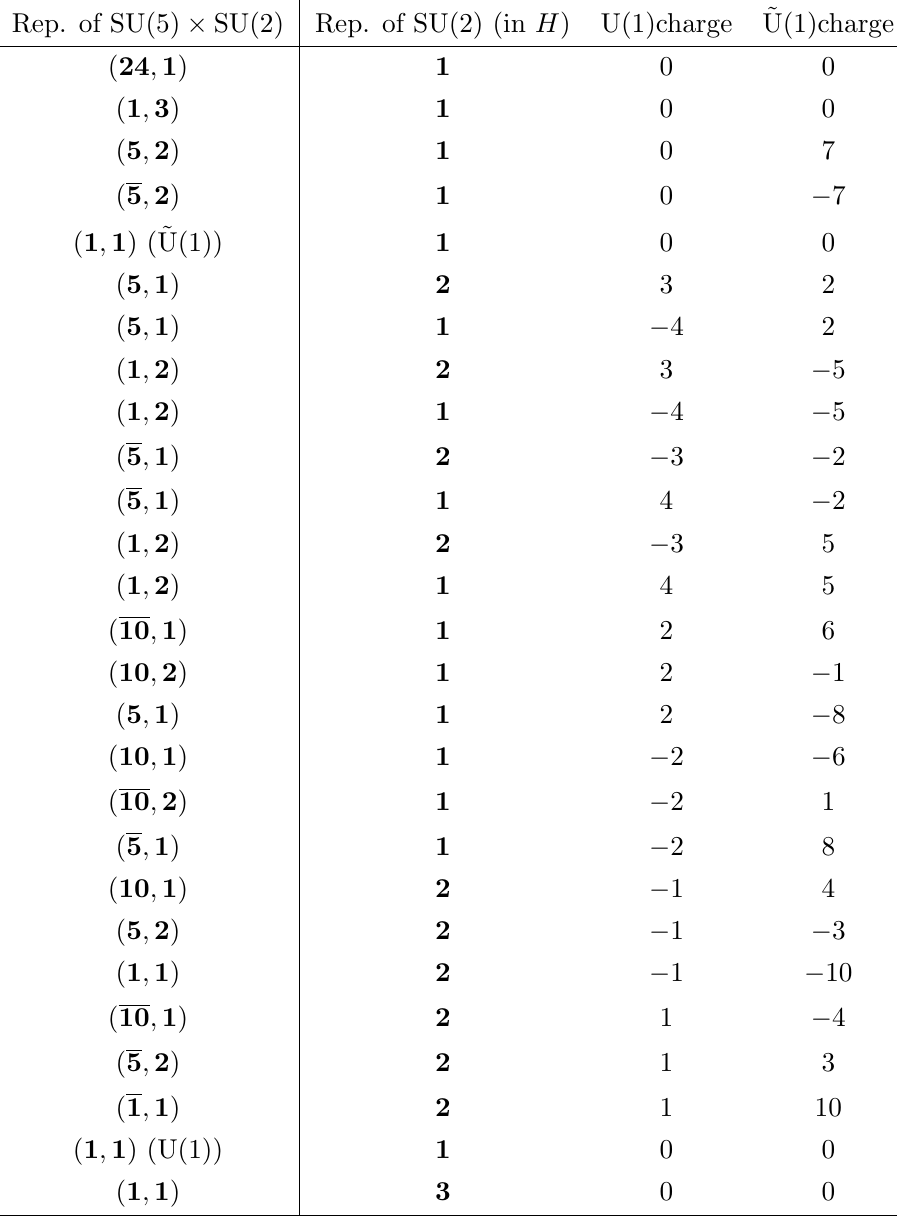
Table 3 . Decomposition of 248